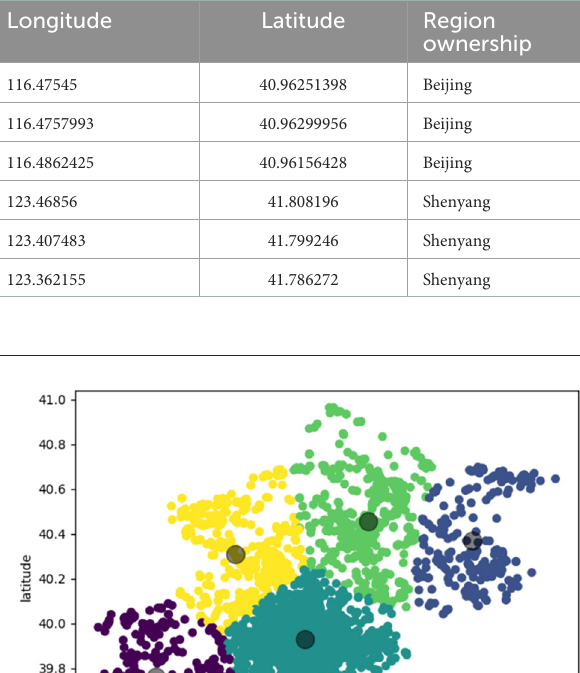
TABLE 2 Sample location information for attractions.